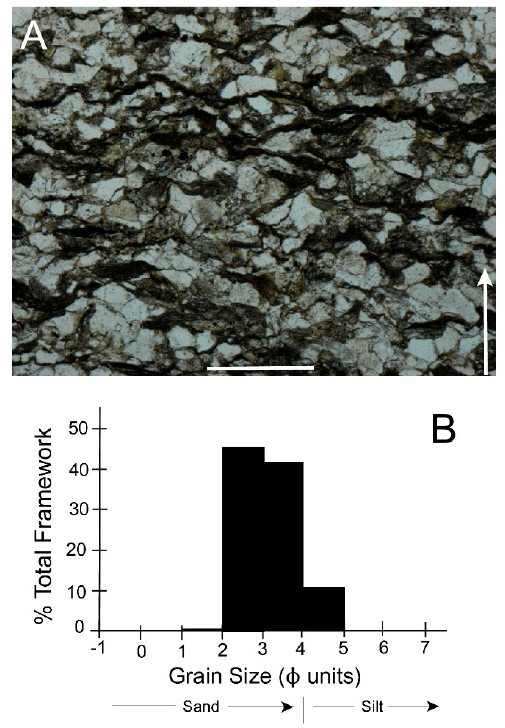
Figure 16. Sedimentologic character of the Towamensing Member of the Catskill Formation, Harrity, PA. ( A ) Thin section of a rock sample collected a few centimeters from the burrow shown in Figure 3A. Arrow shows stratigraphic up direction. Scale bar = 0.5 mm; ( B ) Grain size distribution of framework quartz grains.